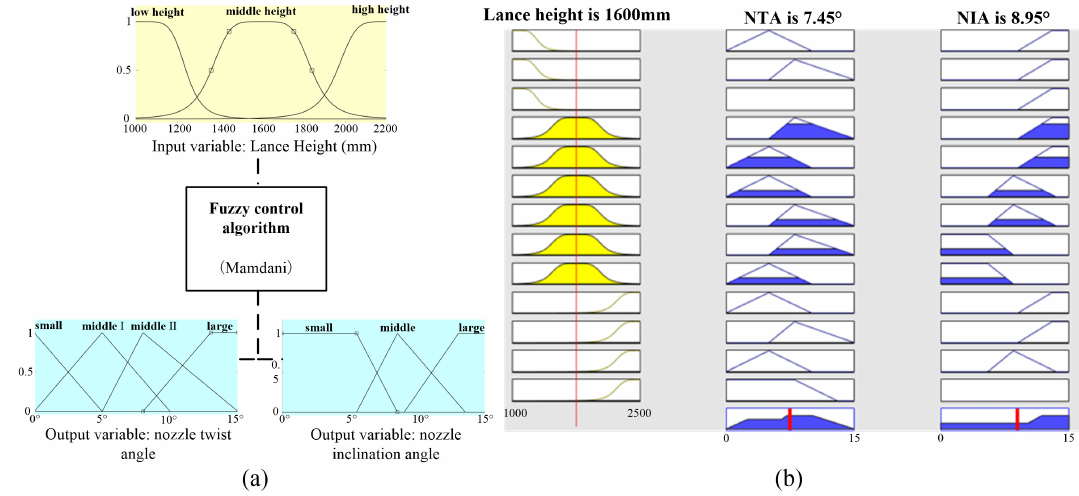
Figure 14. Fuzzy control system for multi-nozzle oxygen lances. ( a ) Three variable membership functions and Mamdani fuzzy system. ( b ) Fuzzy rule diagram of the control system.